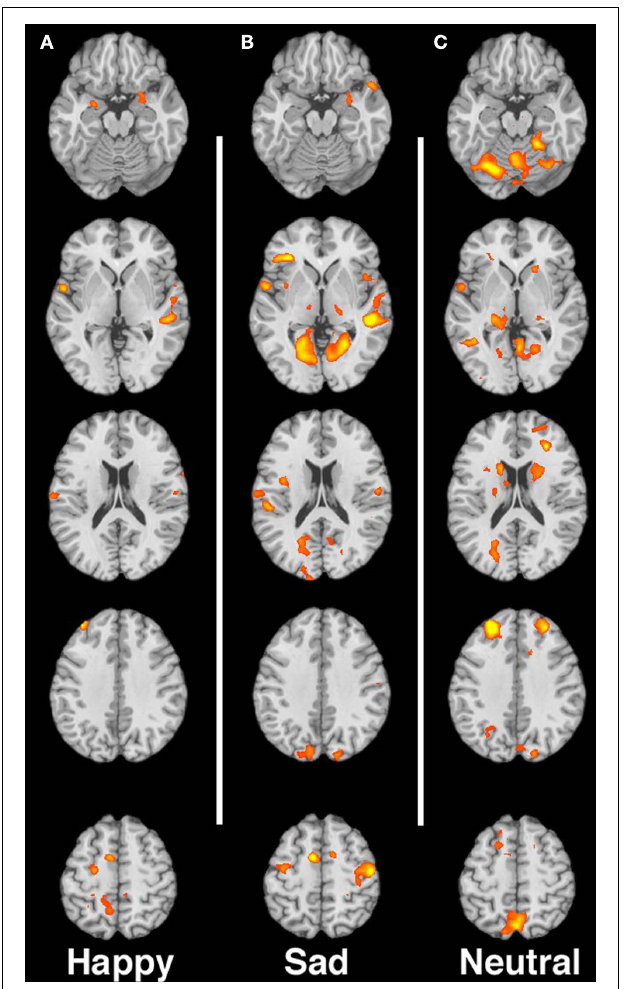
FIGURE 1 | (A–C) Contrast of non-using > substance-using mothers for happy, sad, and neutral faces, respectively. Images are shown in neurological convention, with the left hemisphere on the left side of each image. Slices are at MNI z -coordinate locations − 19, − 1, + 17, + 35, and +